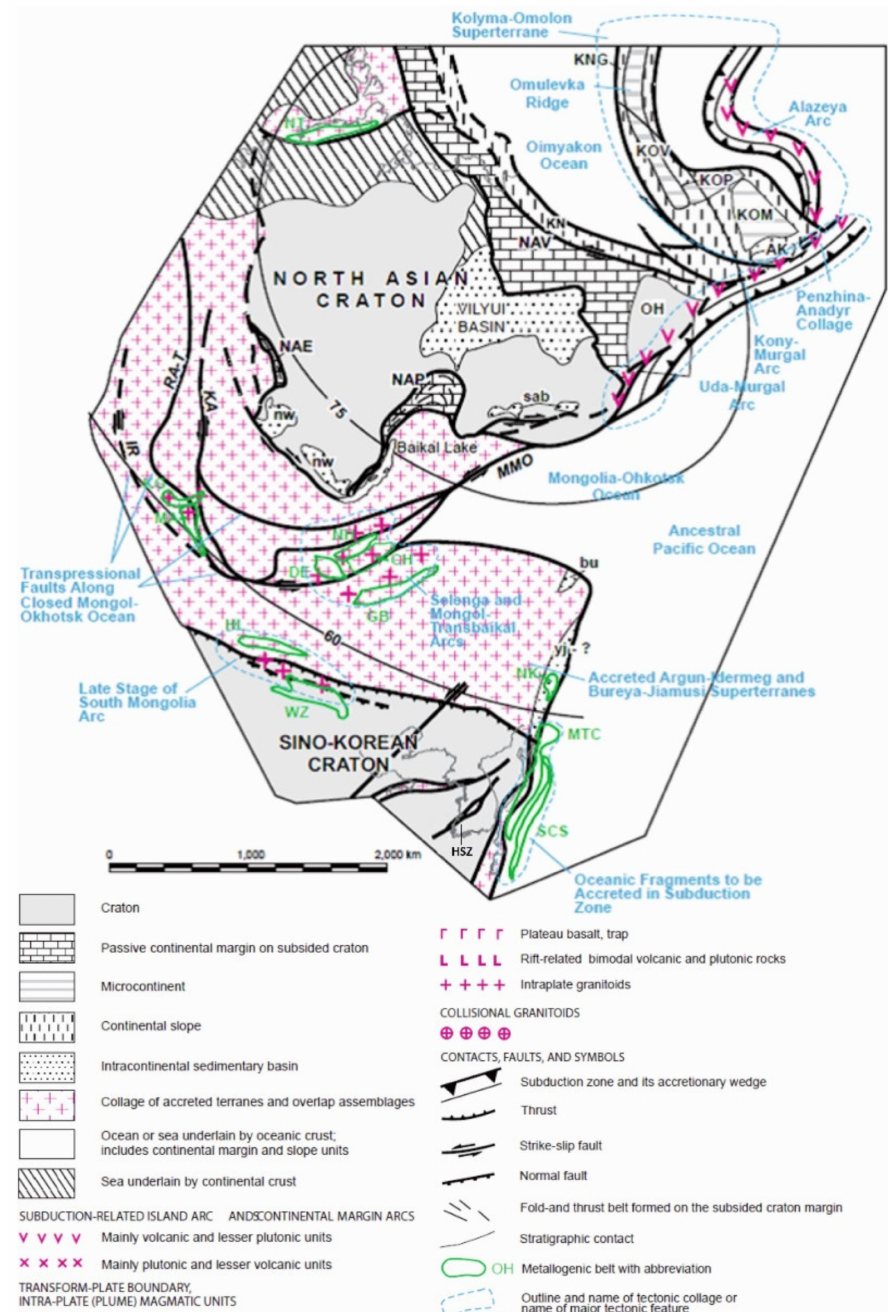
Figure 1. Paleotectonic reconstruction of NE Asia at 210 Ma, showing metallogenic belts of the Triassic–Early Jurassic (230–175 Ma) age [4]. North Asian Craton Margins: